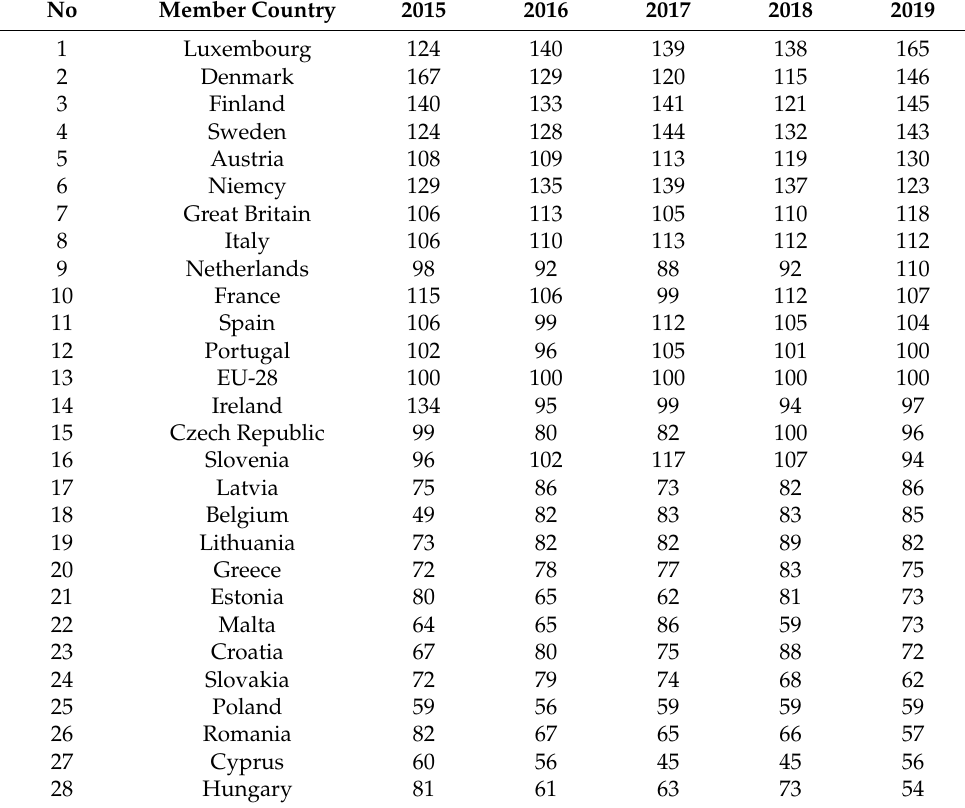
Table 7. Eco-innovation index for European Union countries in 2015–2019.